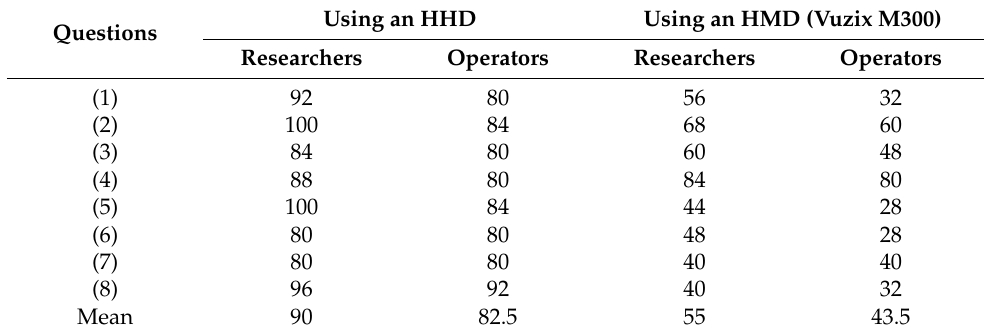
Table 1. The score (%) of testers’ feedback regarding the